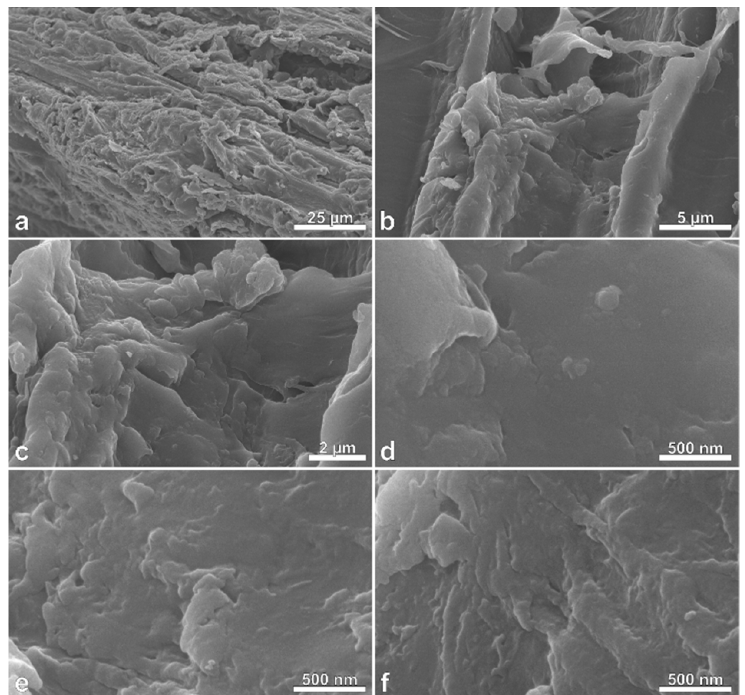
Figure 2. Field emission scanning electron photomicrographs (FESEM) of charcoal produced from massaranduba ( Manilkara huberi ) sawdust at various magnifications, showing the sample surfaces that consist primarily of cell wall material ( a – f ). Note the lack of any significant porous structures in the samples.